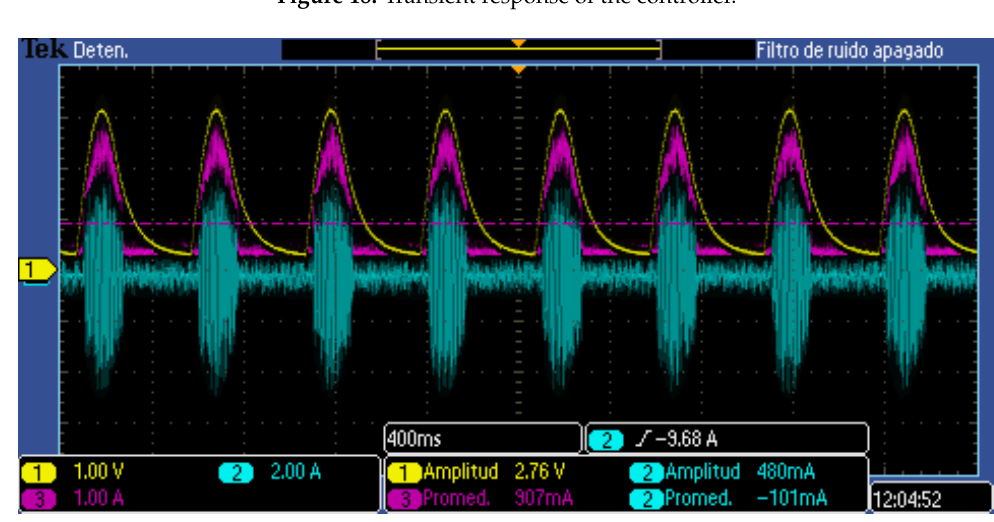
Figure 19. Steady state of the controller.